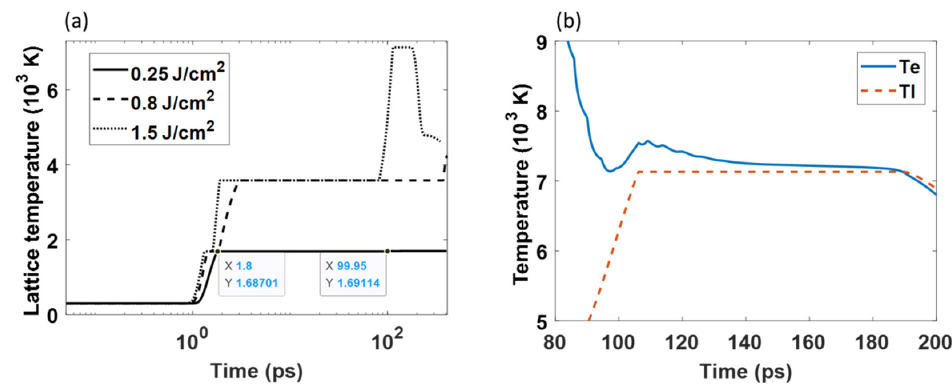
Figure 4. The temporal temperature: ( a ) lattice temperature calculated by different laser fluences, ( b ) the electron and lattice temperatures calculated by 1.5 J/cm 2 fluence at 80–200 ps. After obtaining the threshold of the phase transition by the proposed model, we com- pared the simulation results with the experimental results. First, for the melting threshold, the 𝑚 (cid:3047)(cid:3035) (0.25 J/cm 2 ) calculated by the simulation in this study was matched with previ- ously published results (0.26 J/cm 2 [10] and 0.27 J/cm 2 [35]). The 𝑣 (cid:3047)(cid:3035) (0.80 J/cm 2 ) was matched with the threshold (0.80 J/cm 2 ) mentioned in Section 3.1. The 𝑝ℎ (cid:3047)(cid:3035) (1.5 J/cm 2 ) calculated in this study was close to the threshold (1.67 J/cm 2 ) obtained in our experiments. The threshold of phase transition obtained by simulation was in good agreement with the experimental results.